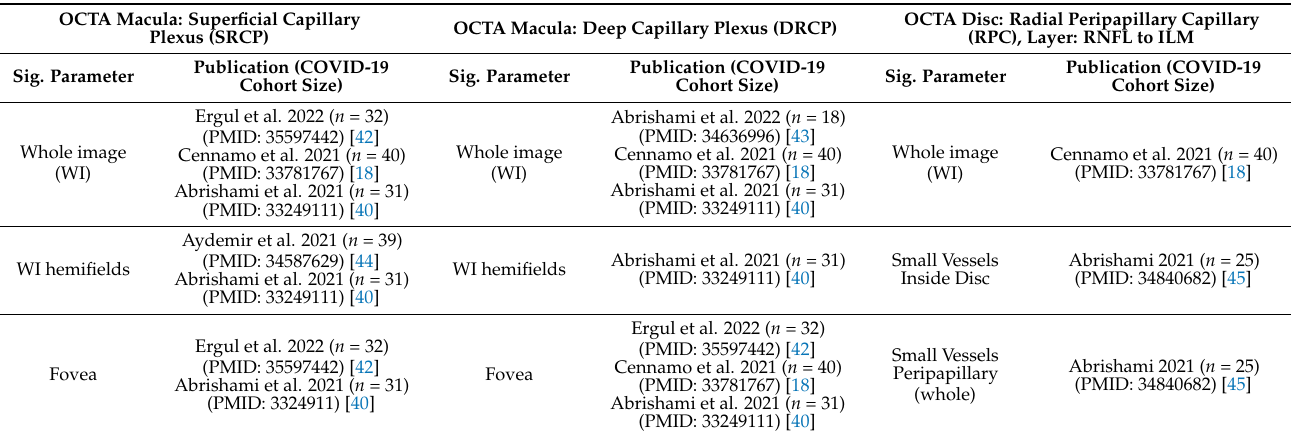
Table 4. Overview of the